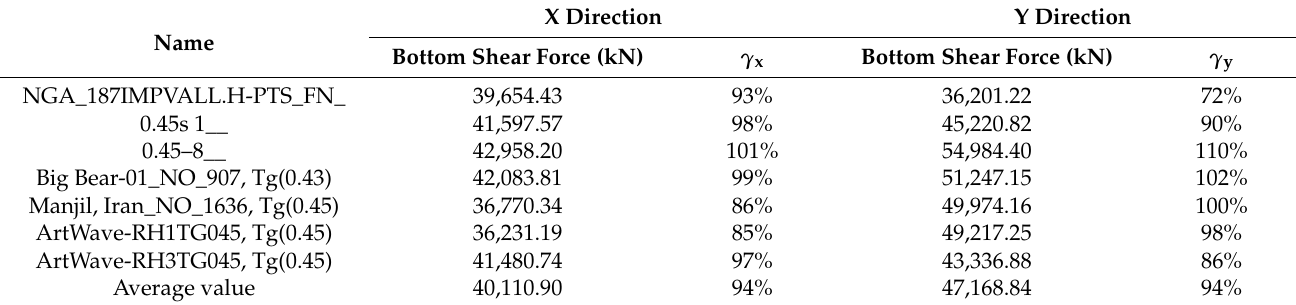
Table 11. Calculated shear forces by the CQC and elastic time history